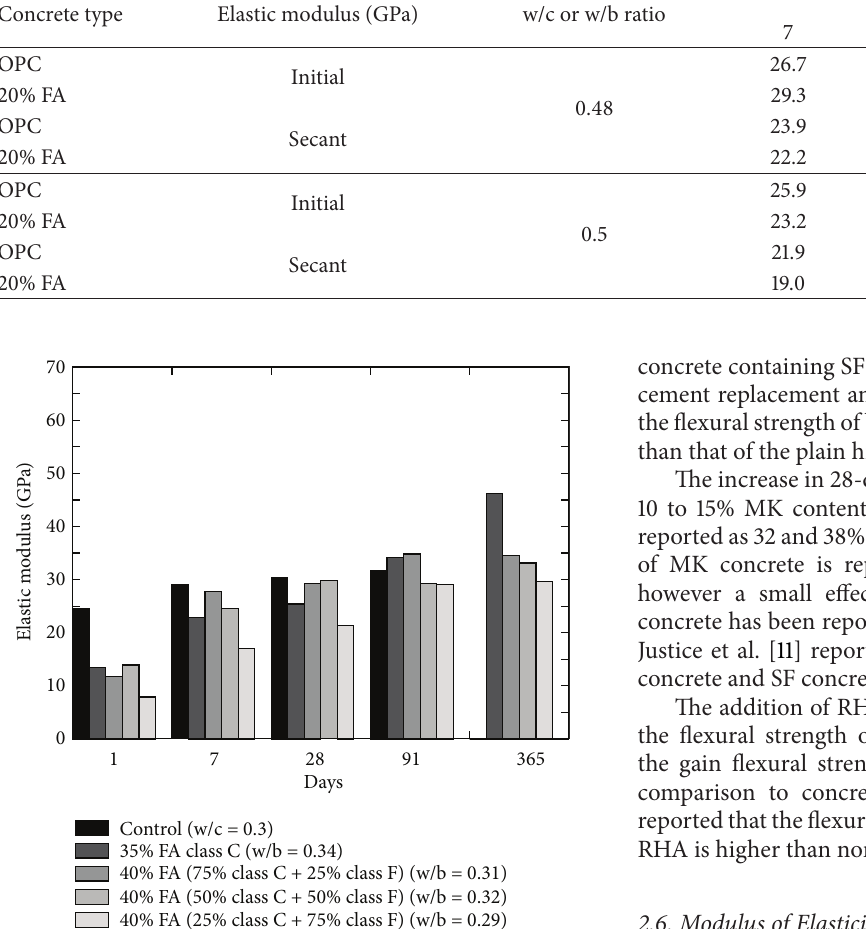
Figure 20: Effect of blended FA on the elastic modulus of concrete